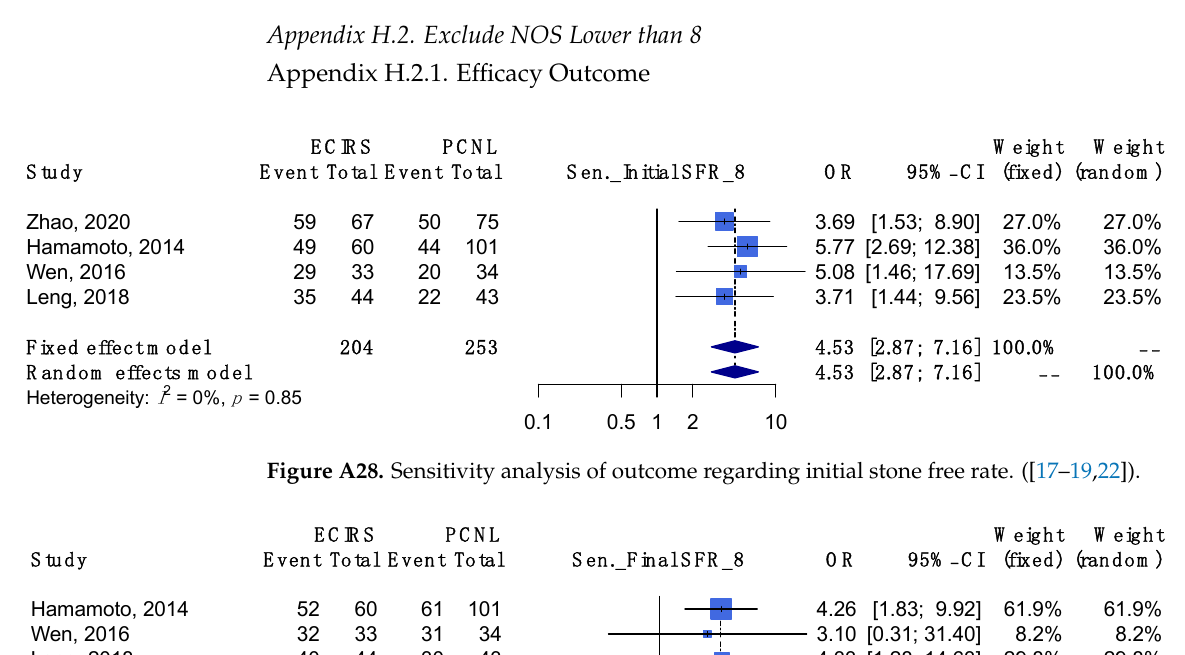
Figure A27. Sensitivity analysis of outcome regarding hospital stay. ([17–20,22,23]).